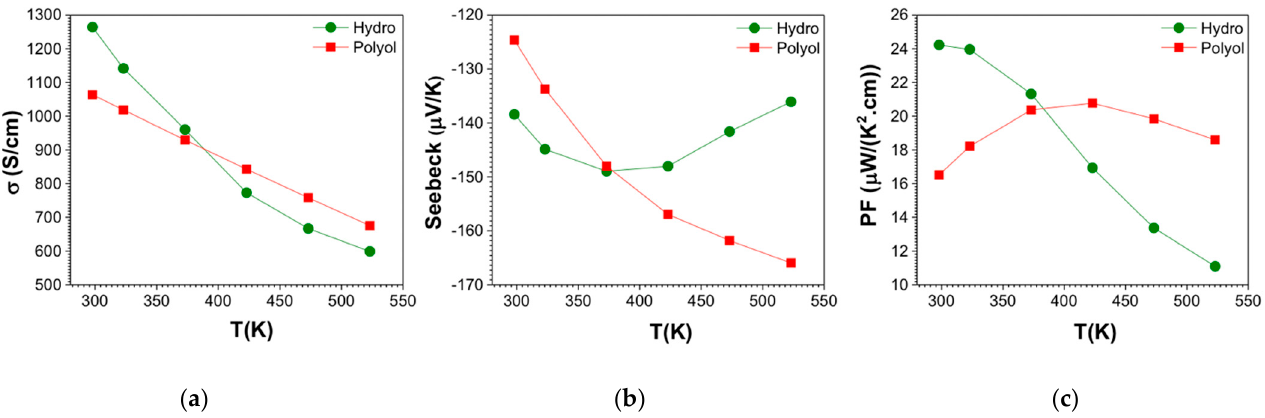
Figure 7. Temperature-dependent electronic transport properties of SPS sintered Bi 2 Te 3 pellets for Bi 2 Te 3 materials synthesized through MW-assisted hydrothermal and polyol routes; ( a ) electronic conductivity, ( b ) Seebeck coefficient, and ( c ) power factor.